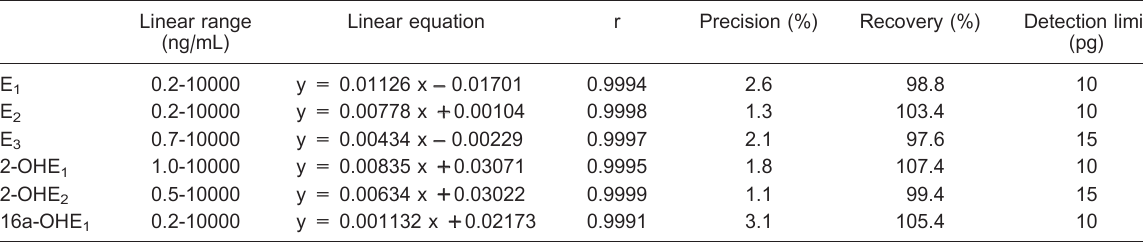
Table 3. Methodology index of estrogen metabolite